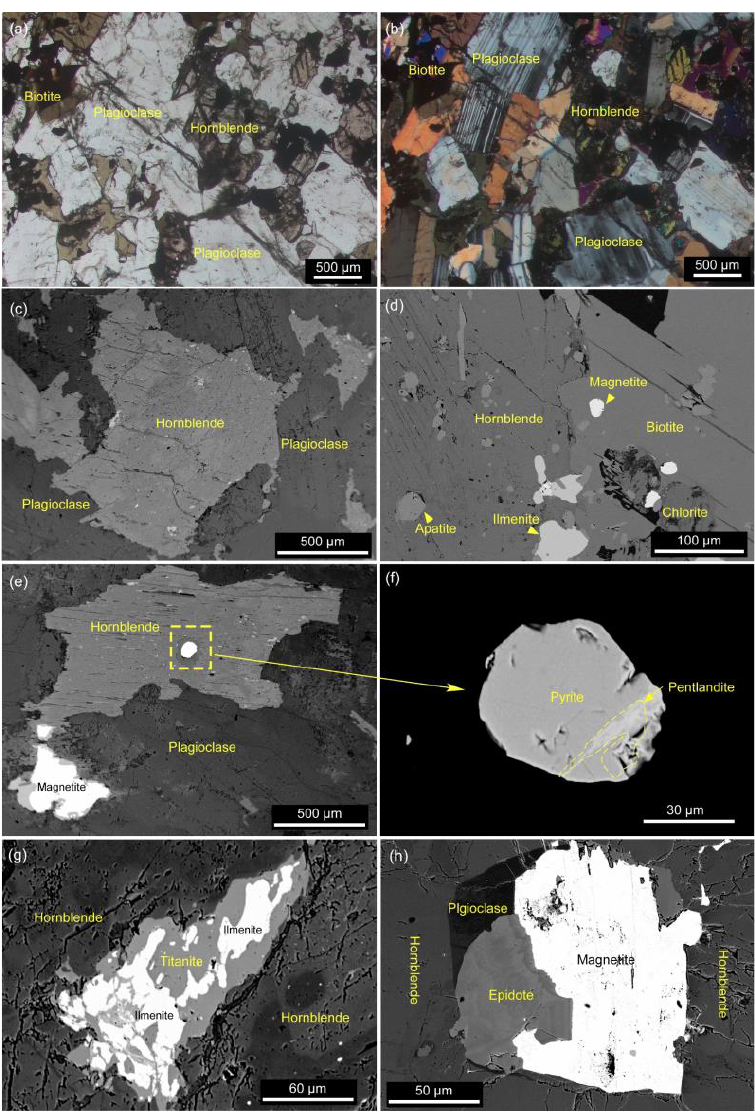
Figure 3. Photomicrographs and back-scattered electron (BSE) images from the Wadi El-Faliq hornblende gabbros showing: ( a , b ) aggregation of plagioclase, hornblende and biotite as major mineral components (a-PPL; b-XPL) in a typical hypidiomorphic texture; ( c ) association of coarse-grained hornblende and plagioclase, typical of granular hypidiomorphic texture; ( d ) intergrowth of hornblende and biotite, where both of them host inclusions of apatite and magnetite, respectively; ( e ) intergrowth of coarse-grained plagioclase, magnetite and hornblende where the later hosts pyrite; ( f ) subhedral pyrite penetrated by pentlandite; ( g ) intergrowth of ilmenite and titanite inside a coarse-grained hornblende crystal; and ( h ) aggregates of plagioclase, epidote and magnetite inside hornblende.